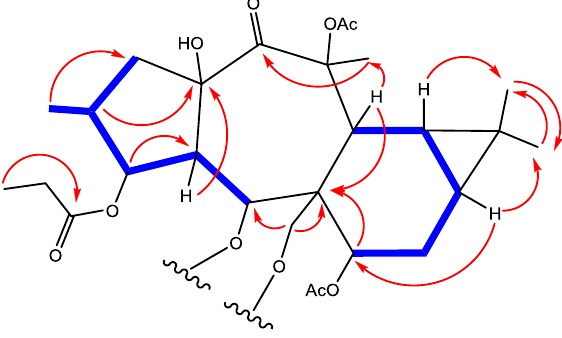
Figure 2. Observed DQF-COSY and HMBC correlations for 1 – 4 .